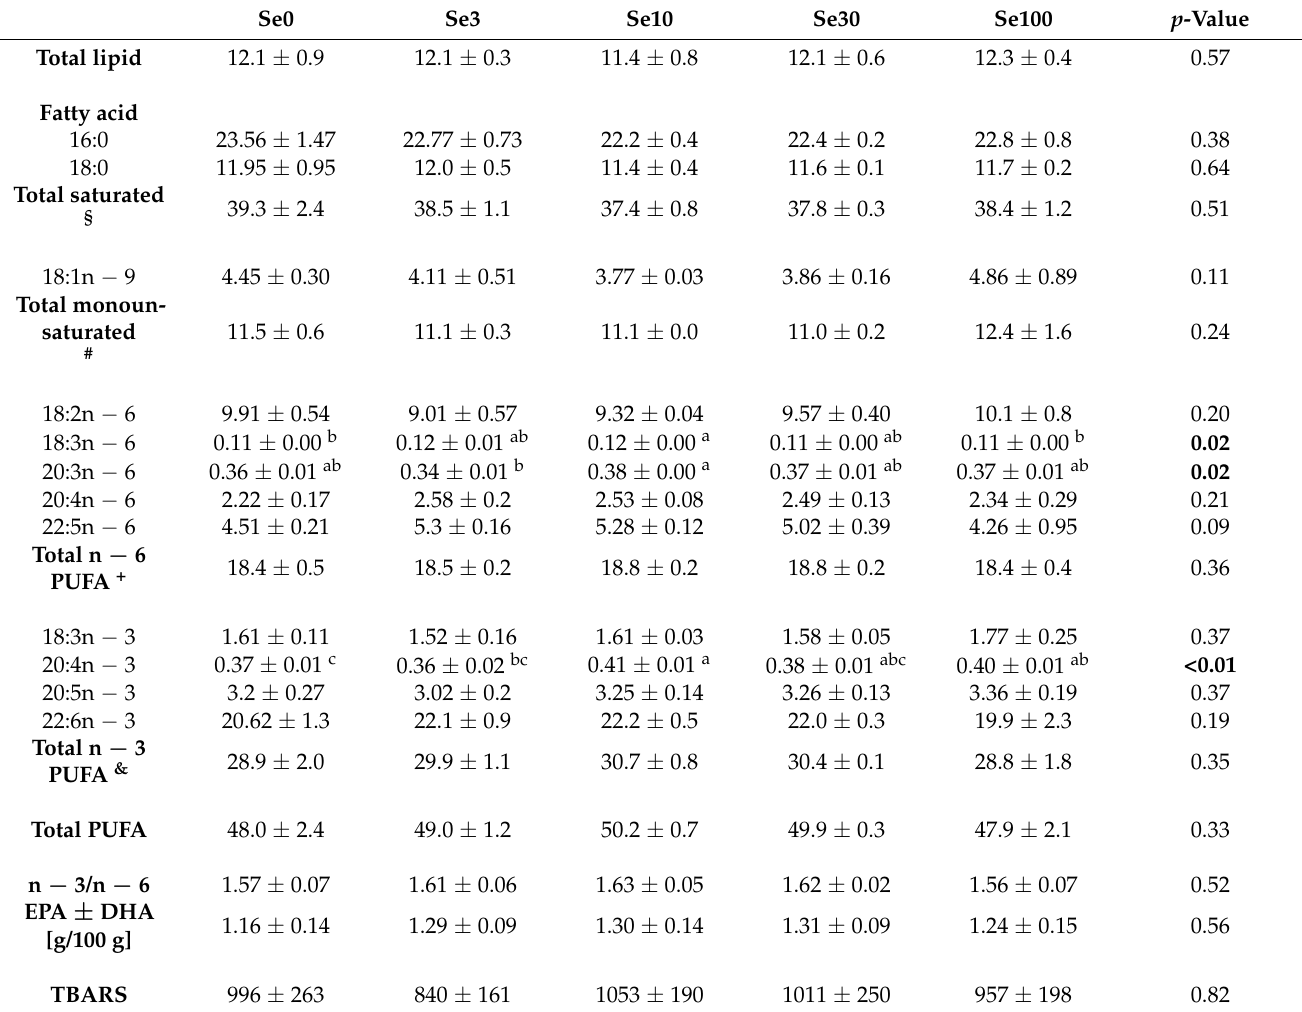
Table 4. Total lipid (mg · g dw − 1 ), fatty acid composition (% of total fatty acids) and TBARS content (nmol · g lipid − 1 ) of ABT larvae fed rotifers Brachionus rotundiformis enriched with Algamac 3050 Bio Marine ® and graded levels of selenium (0, 3, 10, 30, and 100 mg of Se-yeast per 10 6 rotifers) for 13 days. Se0 Se3 Se10 Se30